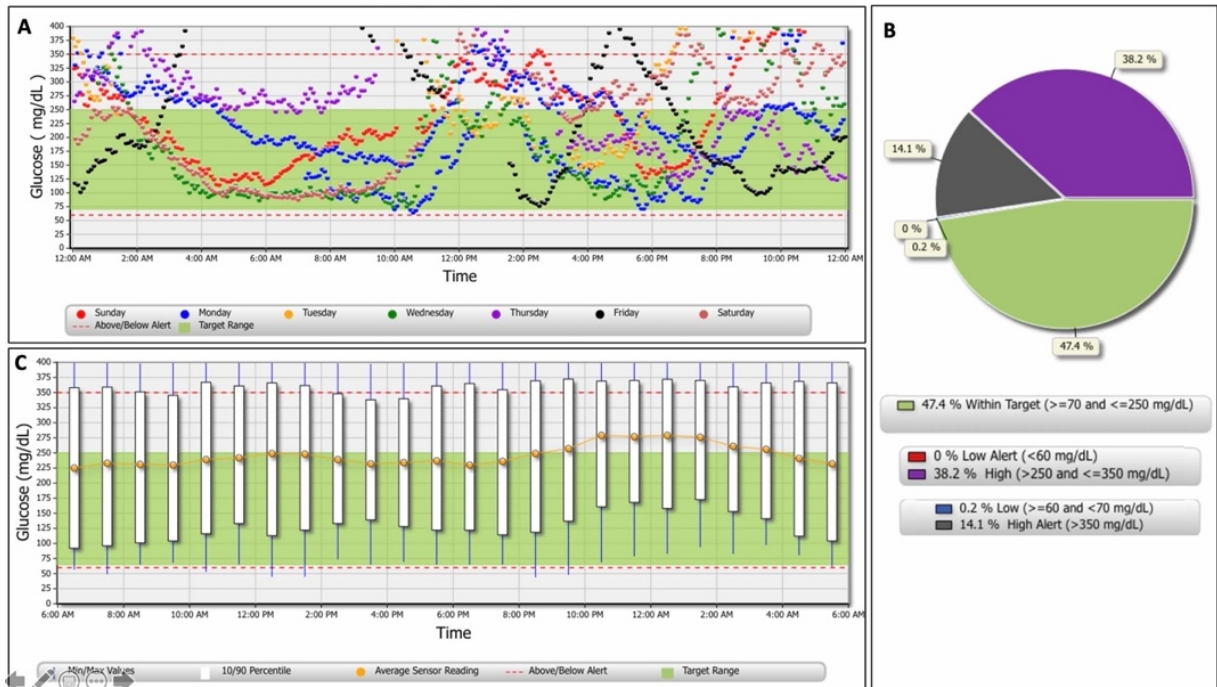
Figure 4. Glucose reports generated by the Eversense Data Management System: ( A ) Glucose trend, divided by days, over a 7-day period. Individual days can be added or removed according to the preferences of the health care providers; ( B ) Glucose pie chart showing the percentage of glucose readings within set ranges over a 180-day period; ( C ) Glucose variability reports over a 180-day period. The legend is represented in the lower part of each report.